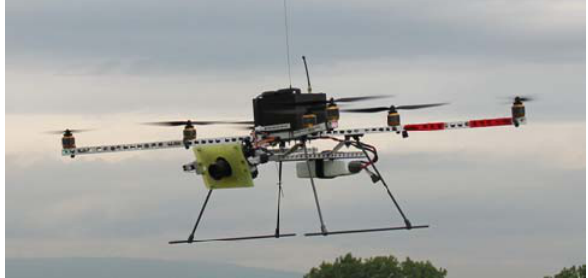
Figure 1. MR-X8 with Tetracam ADC Lite